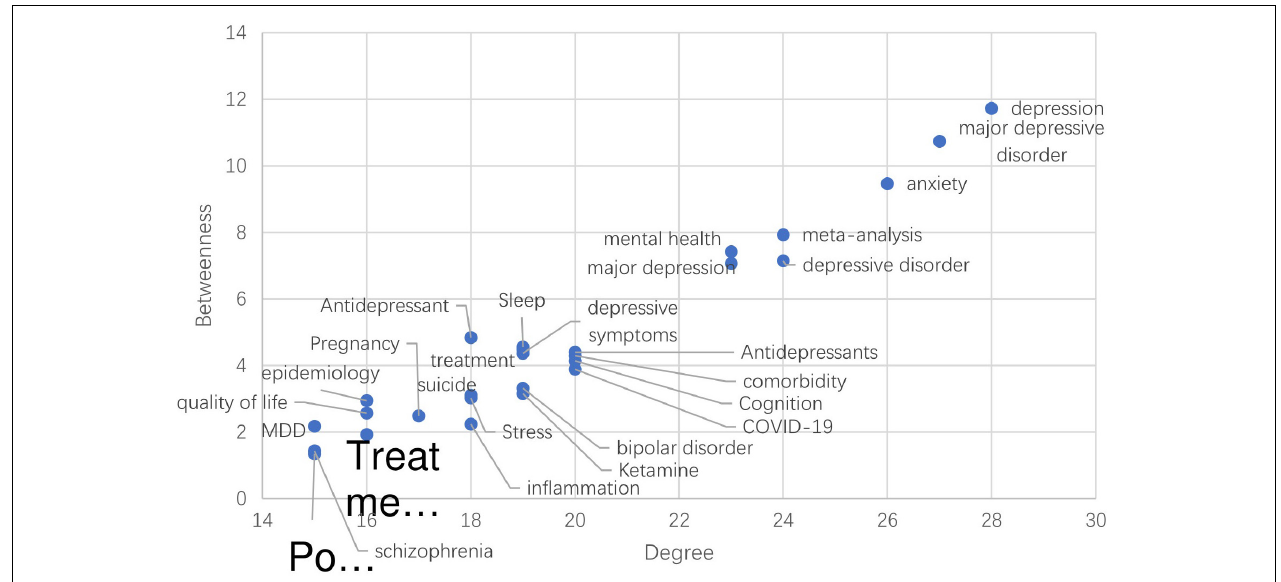
FIGURE 7 | Relationship between two types of centrality distribution of each